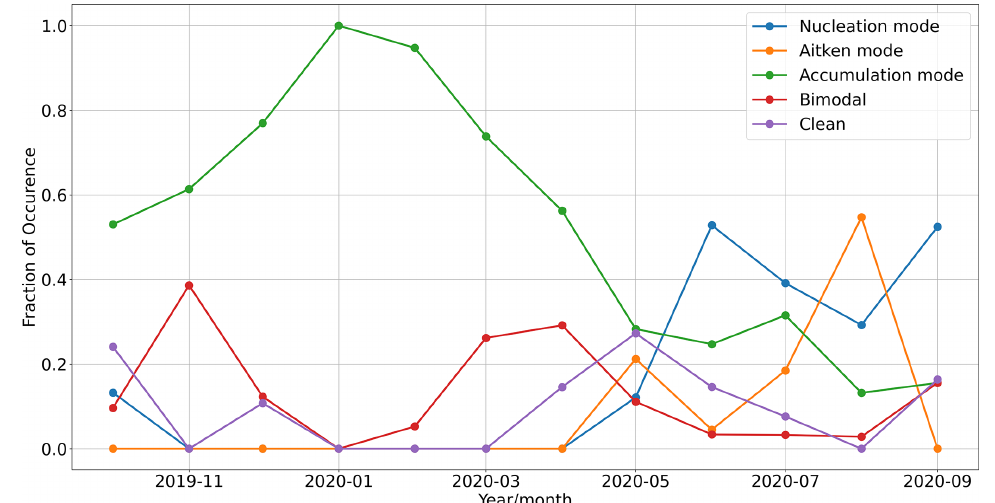
Figure 5. The monthly fraction of occurrence for the PNSD clusters. The fraction of occurrence shows the total number of days per month that each cluster is represented compared to all other PNSD clusters.